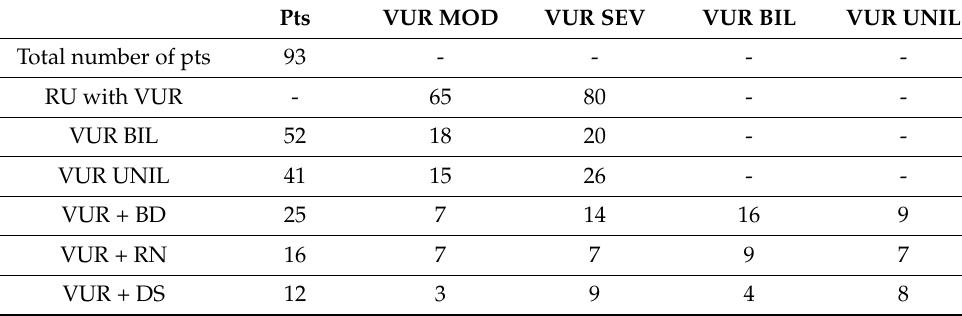
Table 1. Clinical characteristics of children with